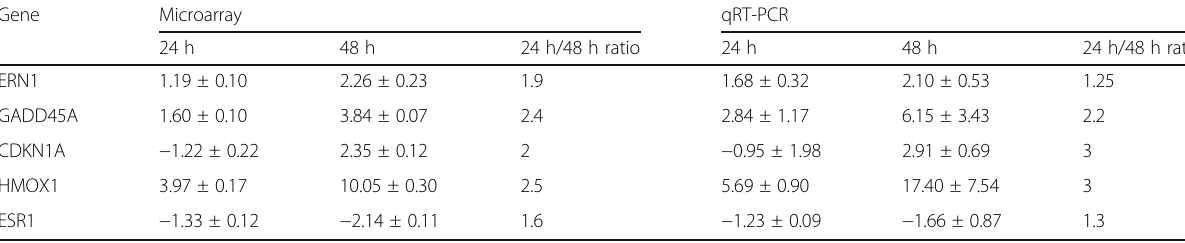
Table 4 Fold changes in expression of 5 genes obtained from qRT-PCR and microarray data Gene Microarray qRT-PCR 24 h 48 h ERN1 GADD45A HMOX1 Each value represents mean±SD ( n